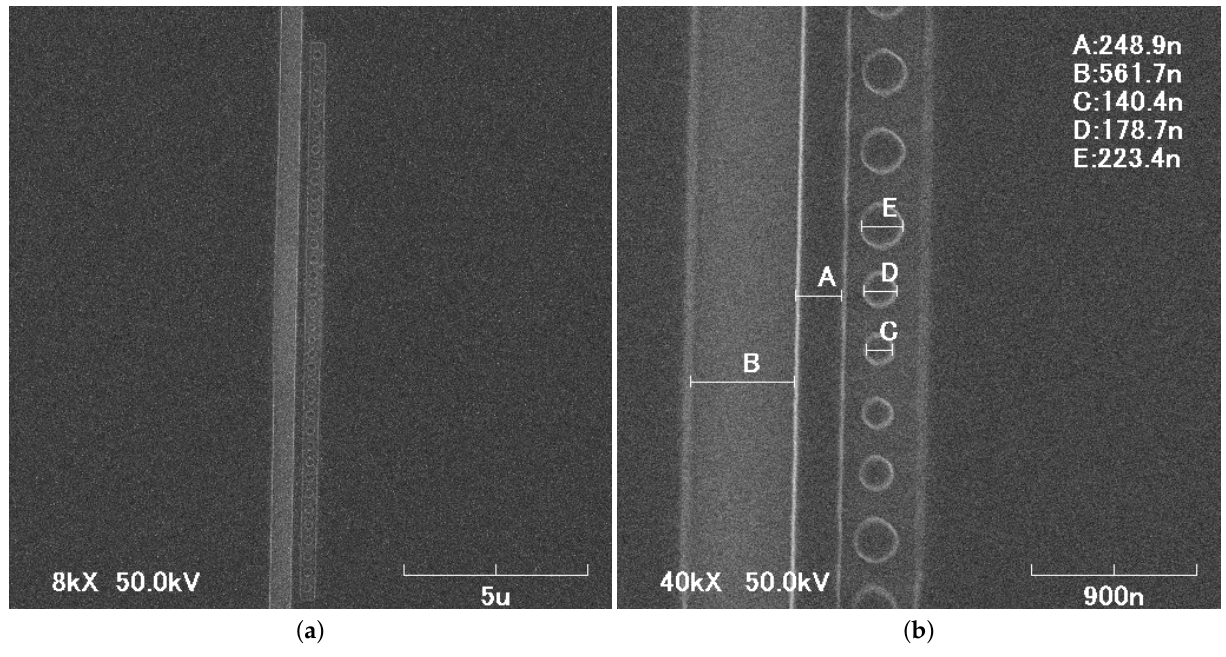
Figure 5. ( a ) SEM image of the fabricated photonic crystal nanobeam; ( b ) close-up of the nanobeam including measurement of the coupling gap (A), waveguide width (B), and hole diameters (C–E) of the photonic cavity (units are in